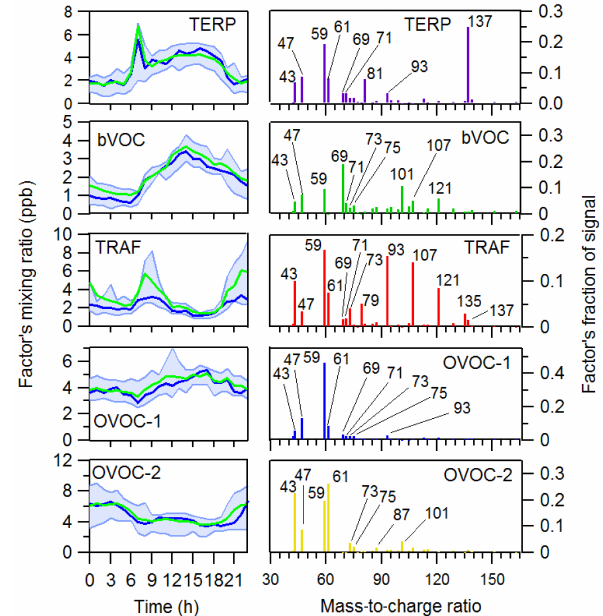
Figure 7. Species percentage (%) attributed to the various PMF fac- tors for the Patras summer campaign. Figure 8. Results of Athens summer campaign PMF analysis. The left side shows the diurnal profiles of the factors. Green lines present the average values. The median value is shown with blue. The blue area is the interquartile range. The right side presents the m/z com- position of each factor as a fraction of signal for each m/z